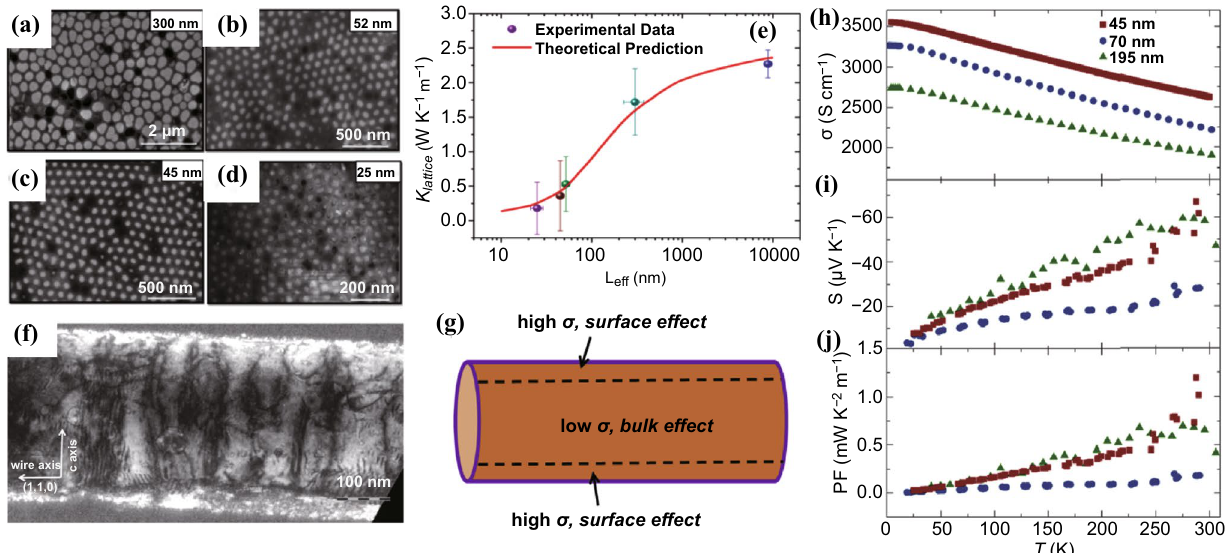
Fig. 10 SEM images of a 300 nm, b 52 nm, c 45 nm and d 25 nm average diameter Bi 2 Te 3 NWs. e κ L of the NWs versus diameters. f TEM image of a Bi 2 Te 3− y Se y ternary NW. g Schematic of the NW showing the contribution of the surface states with a high σ , whereas bulk part yields a low electrical conductivity and a high S . Temperature-dependent h electrical conductivity, i Seebeck coefficient and j power factor of Bi 2 Te 3− y Se y ternary NWs of three different diameters (45, 70 and 195 nm). Adapted with permission from Refs. [137,